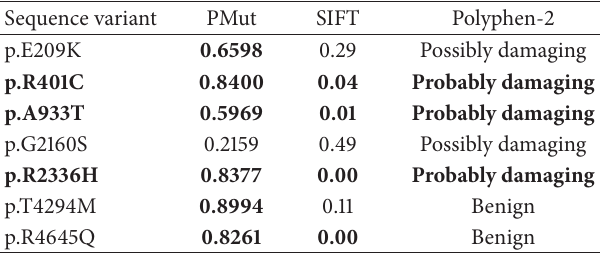
Table 2: In silico analysis of RYR1 sequence variants reported in patients who experienced ER and stress-induced MH